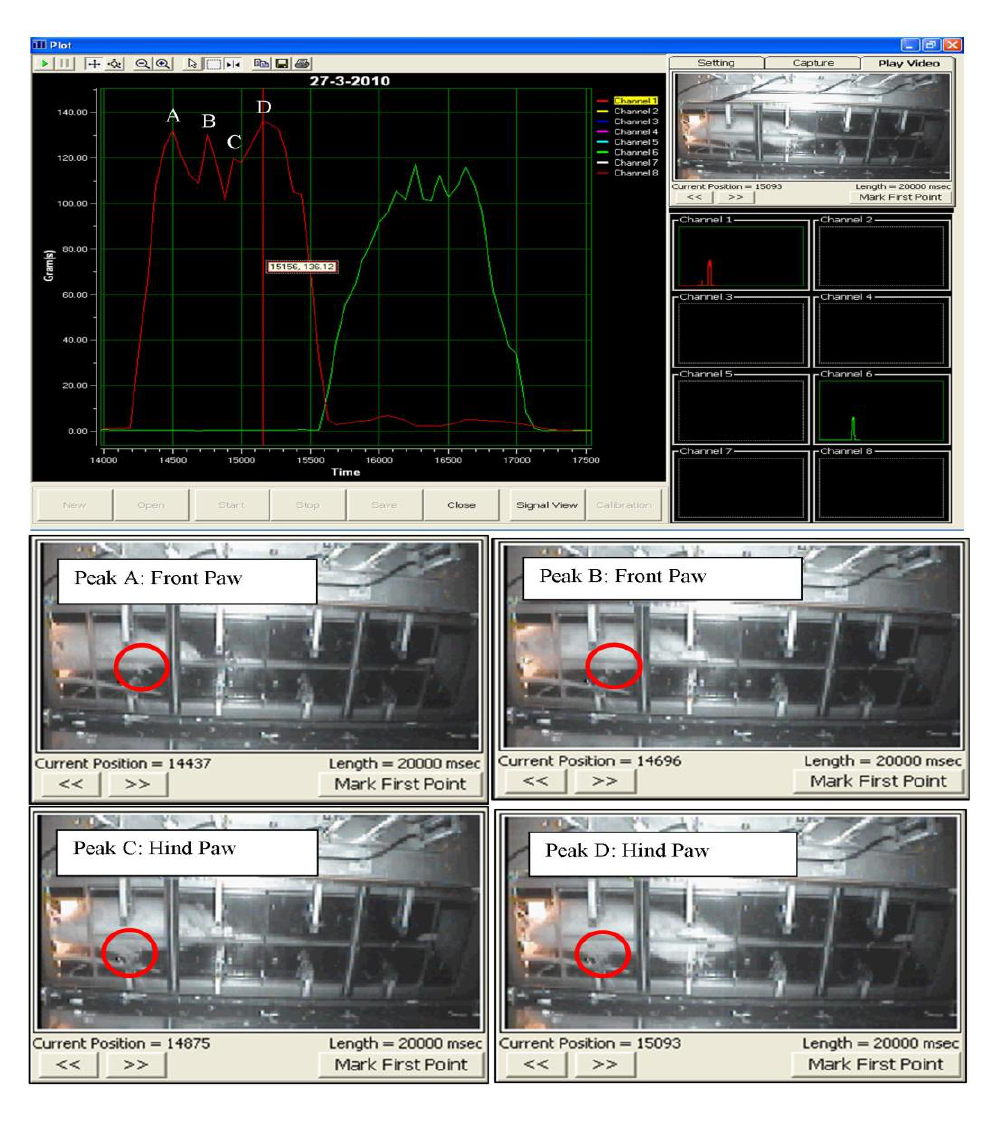
Figure 9. Uncertain occurrence of a peak signal. During the rat locomotion, the stepping forces were captured and displayed in real-time signal display frame and video display frame concurrently. The four peak signals which are showed in channel 1 are represented in (A) front paw (B) front paw (C) hind paw (D) hind